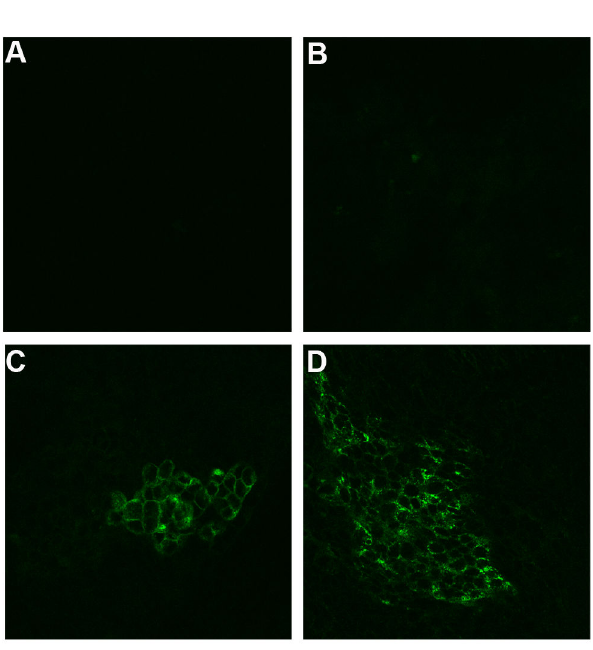
Figure 2. Labeled ricin bound to polarized HCT-8 cells on transwell membranes. Polarized HCT-8 cell monolayers or AlexaFluor ® 488-labeled ricin (B, C, D). At 4 (A, B), 8 (C), excised and cells were visualized with a confocal